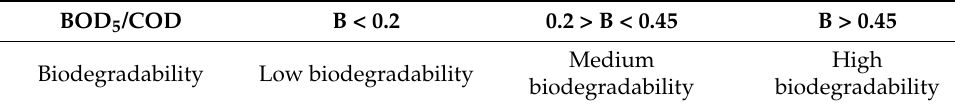
Table 1. Biodegradability according to BOD 5 /COD ratio. BOD 5